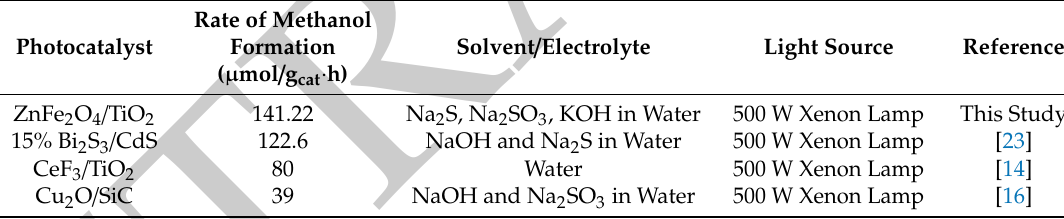
Table 4. Comparison with previous